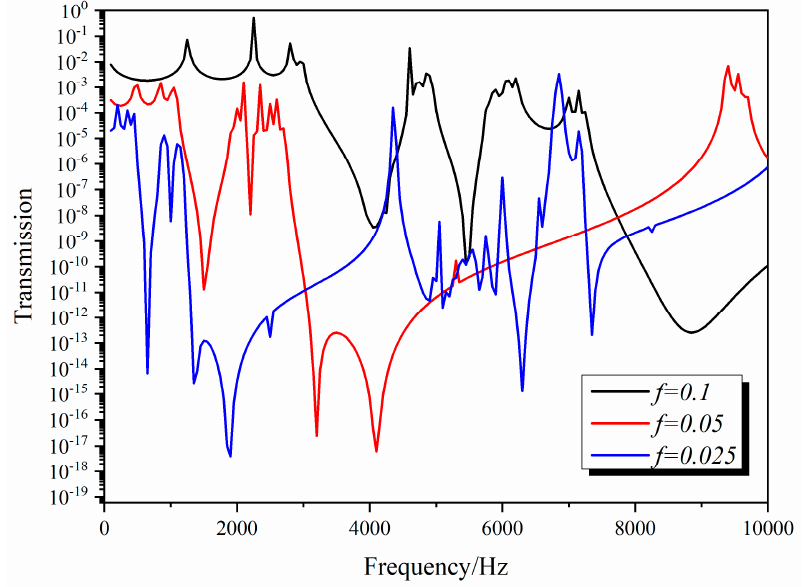
Figure 9. Dependence of the transmission curves of the 3D star structure on f .